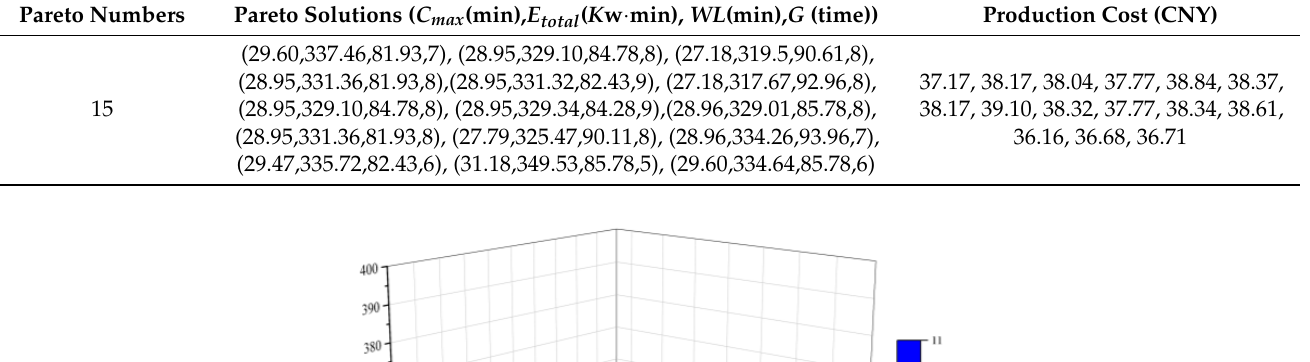
Table 8. Cutting-tool degradation model.